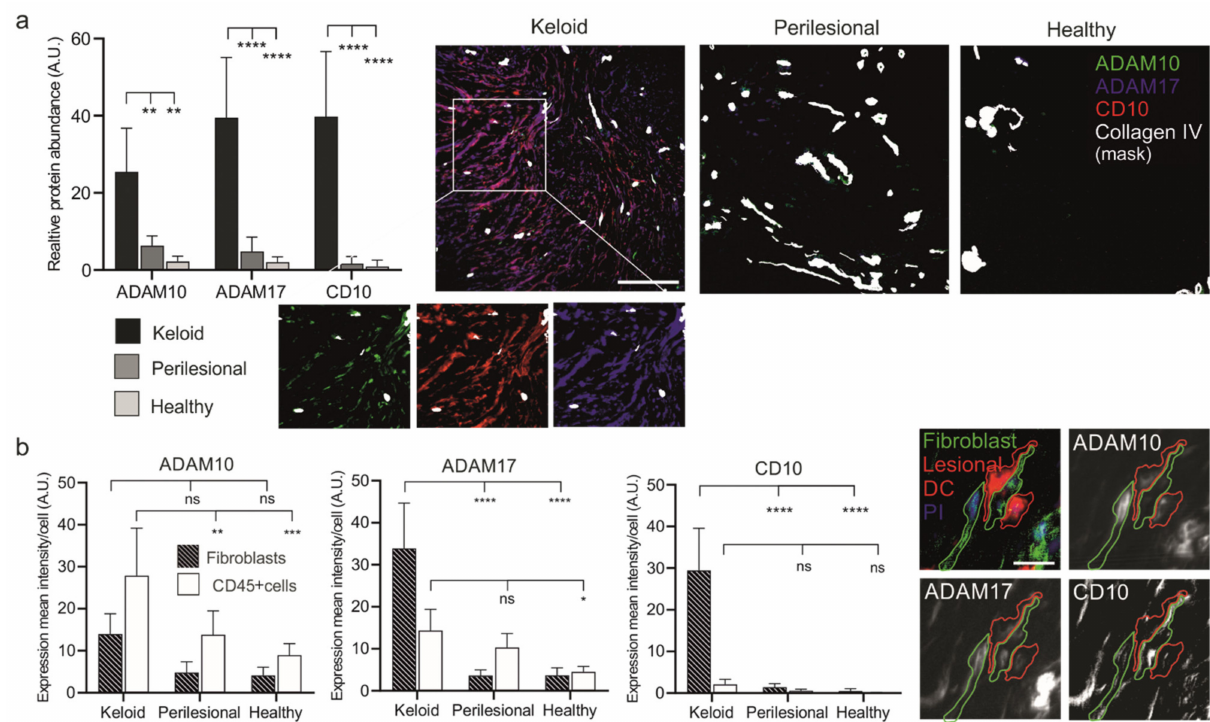
Figure 4. Increased expression levels of metalloproteases in keloid patients. ( a ) Tissue sections of keloid, perilesional and control skin were systematically analyzed for metalloproteinase expression by MAA. Quantification of the differ- ent metalloproteases (left panel). Relative expression levels of proteases were determined by assessing the grey value intensity. The respective stainings are shown in co-localization images representing an overlay of four markers (ADAM 10, ADAM17, CD10 and a Collagen type IV-mask). Individual close-up images for KD visualize the expression of the proteases. Scale bars = 200 µ m. ( b ) Mean expression levels of ADAM 10, ADAM17 and CD10 in fibroblasts and CD45+ cells. MAA-image gallery showing the expression of analyzed proteases in fibroblasts (green encircled cells) and inflammatory DCs (red encircled cells) in keloid tissue. Fibroblasts were defined by using anti-fibroblast antibody plus CD45 negative signal, and lesional DCs by anti-CD1a, anti-CD11c and anti-CD14 antibodies. Scale bars = 10 µ m. Data are means ± SEM from n patients ( n (Keloid) = 8, n (perilesional) = 6, n (control) = 5). Statistical significance was assessed based on the p value (ns p > 0.5, * p < 0.05, ** p < 0.01, *** p < 0.001, **** p < 0.0001) and determined using two-way ANOVA and Tukey’s